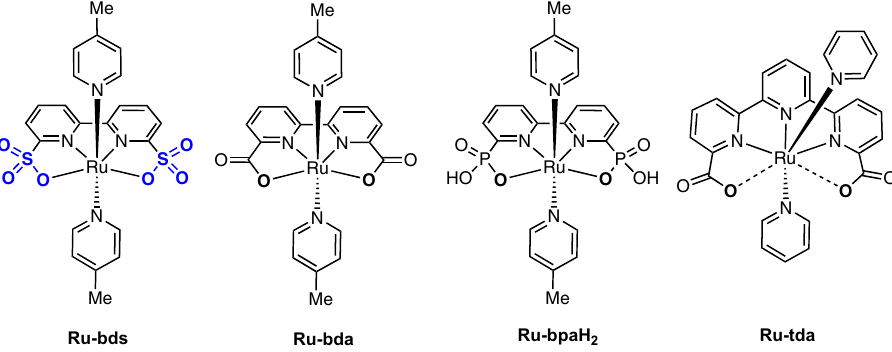
Fig. 1 Structure illustration of complexes. Chemical structures of Ru-bds , Ru-bda , Ru-bpaH 2 and Ru-tda